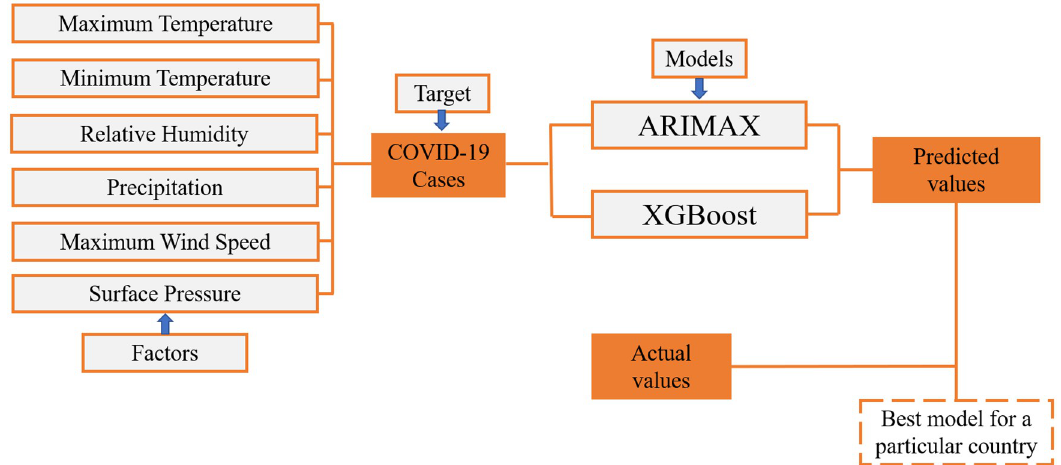
Fig 1. Schematic of the proposed